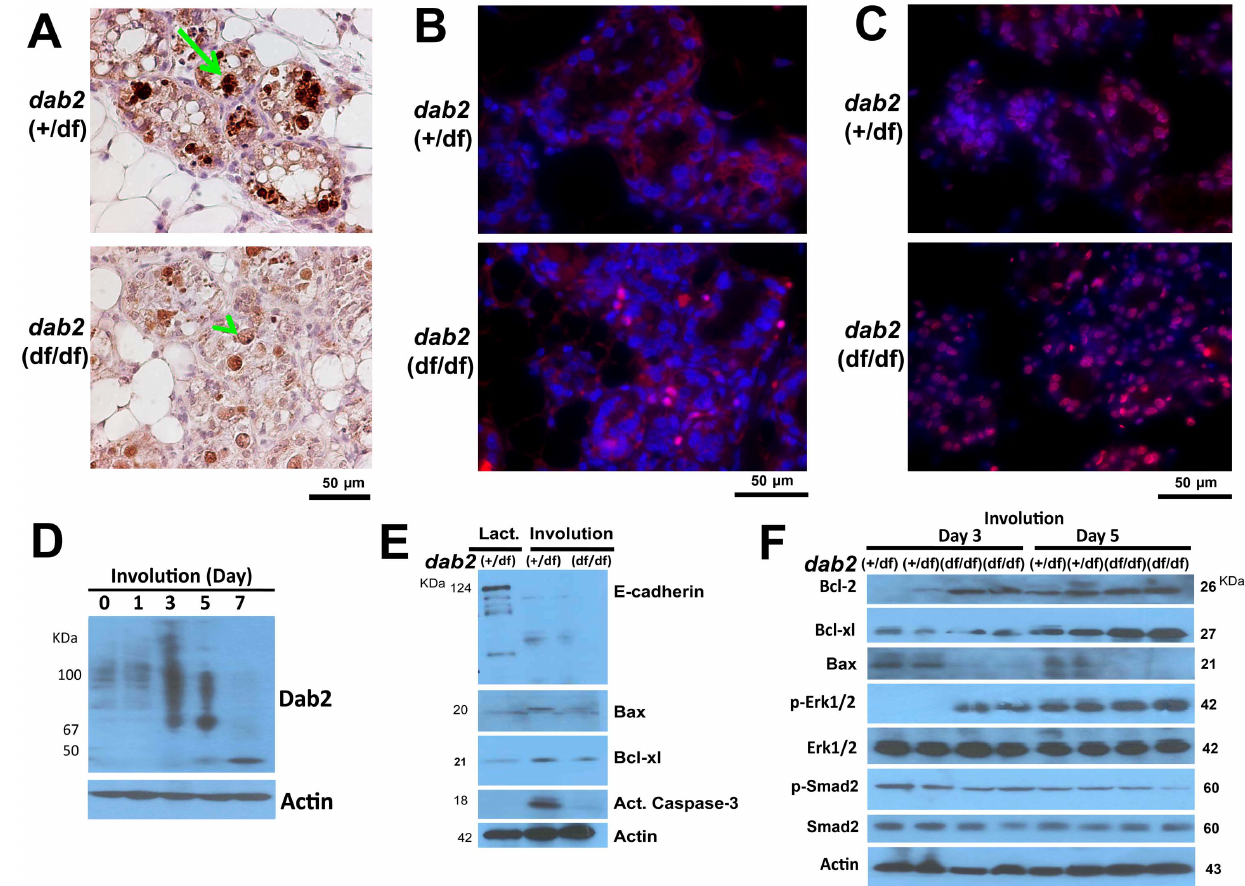
Figure 6. Delayed apoptosis of Dab2-deficient mammary epithelial cells during involution. ( A ) The day 3 involuting mammary glands from control ( dab2 heterozygous) and dab2 knockout ( dab2 (f/df):Sox2-Cre) mice were analyzed. Apoptotic cell death in situ indicated by immunostaining for activated caspase-3, comparing wildtype (arrow) and Dab2 deficient cells (arrowhead). ( B ) A representative immunofluorescence microscopy staining for phospho-Erk1/2 in Dab2 heterozygous and knockout mammary glands on day 3 of involution. Phospho-Erk1/2 (red) overlaying on DAPI (blue) stainings are shown. ( C ) Immunofluorescence microscopy for Bcl-2 (red) and DAPI (blue) staining of day 3 involuting mammary glands. ( D ) Dab2 expression was determined by Western blot of tissue extracts of involuting mammary glands from dab2 heterozygous mice at 0, 1, 3, 5, and 7 days following forced involution. ( E ) Western blot analysis of E-cadherin, Bax, Bcl-xl, and activated caspase-3. Mammary protein extracts from heterozygous lactating (day 12) and forced involuting (day 3) mice were analyzed. ( F ) Western blot analysis of Bcl-2, Bcl-xl, Bax, phospho-Smad2, total Smad2, phospho-Erk1/2, and total Erk1/2 in protein lysates extracted from mammary glands following 3 and 5 days of forced involution. Two independent samples (duplicate) of each genotype from different mice are shown in the blot. ( Figure 4E , arrowhead) compared to adjacent Dab2-positive cells ( Figure 4E , arrow). We have consistently detected the genotype- dependent changes in multiple slides from 3 controls (both wildtype and heterozygous) and 3 conditional deletions. Additionally, when available, we used slides containing regions showing Dab2-positive and negative adjacent cells for analysis to demonstrate a change depending on Dab2 expression.